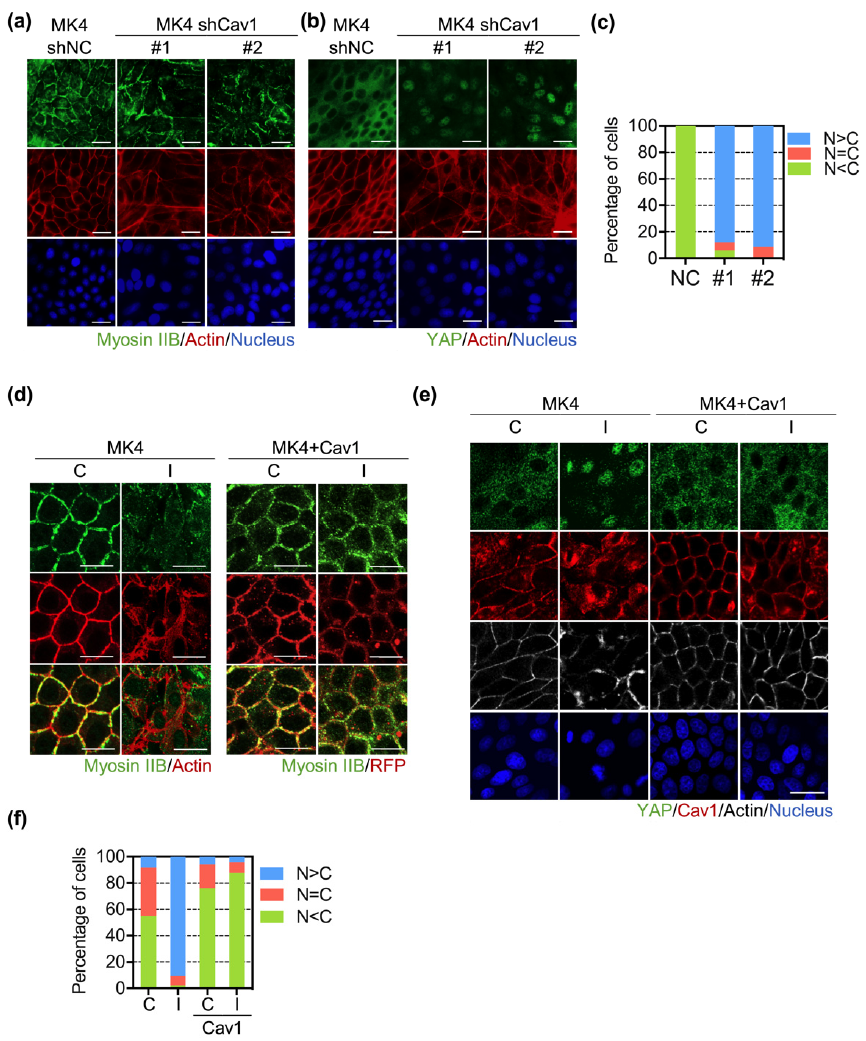
Figure 3. Downregulation of Cav1 mediated Ha-Ras V12 -induced cell junction disruption and YAP nuclear translocation. Knockdown of Cav1 in MK4 cells cultured at overconfluent stage. Two MK4 shCav1 cell lines were used, including MK4 shCav1 #1(#1) and MK4 shCav1 #2 (#2). MK4 shNC (NC) was used as knock-down control cell line. ( a ) Representative immunofluorescence images of MK4 cells at the confluent stage, which were stained with myosin IIB (green), Phalloidin (red), and Hoechst 33,258 (blue). Scale bar = 20 µm. ( b ) Representative immunofluorescence images of MK4 cells at the confluent stage, which were stained with YAP (green), Phalloidin (red), and Hoechst 33,258 (blue). Scale bar = 20 µm. ( c ) Percentage of cells with predominant nuclear YAP localization (N > C), equal nuclear and cytosol YAP localization (N = C), and predominant cytosol YAP localization (N < C). MK4 cells were overexpressed with RFP-conjugated Cav1. Cells’ overexpression of Cav1 was treated with or without IPTG (5 mM) for 24 h at the overconfluent stage. ( d ) Representative confocal images of MK4 cells at the confluent stage, which were stained with myosin IIB (green) and Phalloidin (red). Scale bar = 20 µm. ( e ) Representative confocal images of MK4 cells at the confluent stage. Cells were stained with YAP (green), Cav1 (red), Phalloidin (gray), and Hoechst 33,258 (blue). Scale bar = 20 µm. ( f ) Percentage of cells with predominant nuclear YAP localization (N > C), equal nuclear and cytosol YAP localization (N = C), and predominant cytosol YAP localization (N < C).